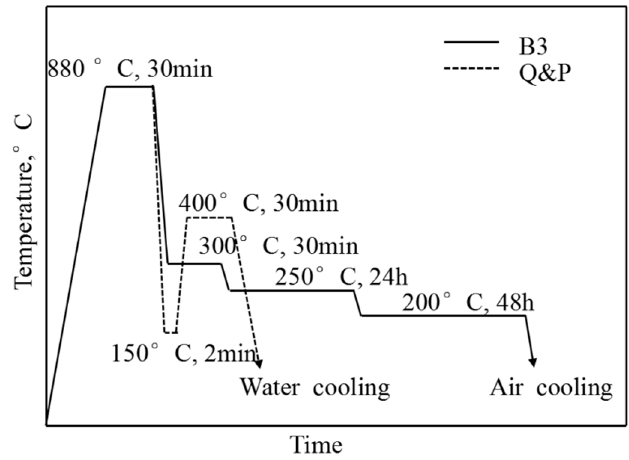
Figure 1. The schematic illustration of different heat treatments.